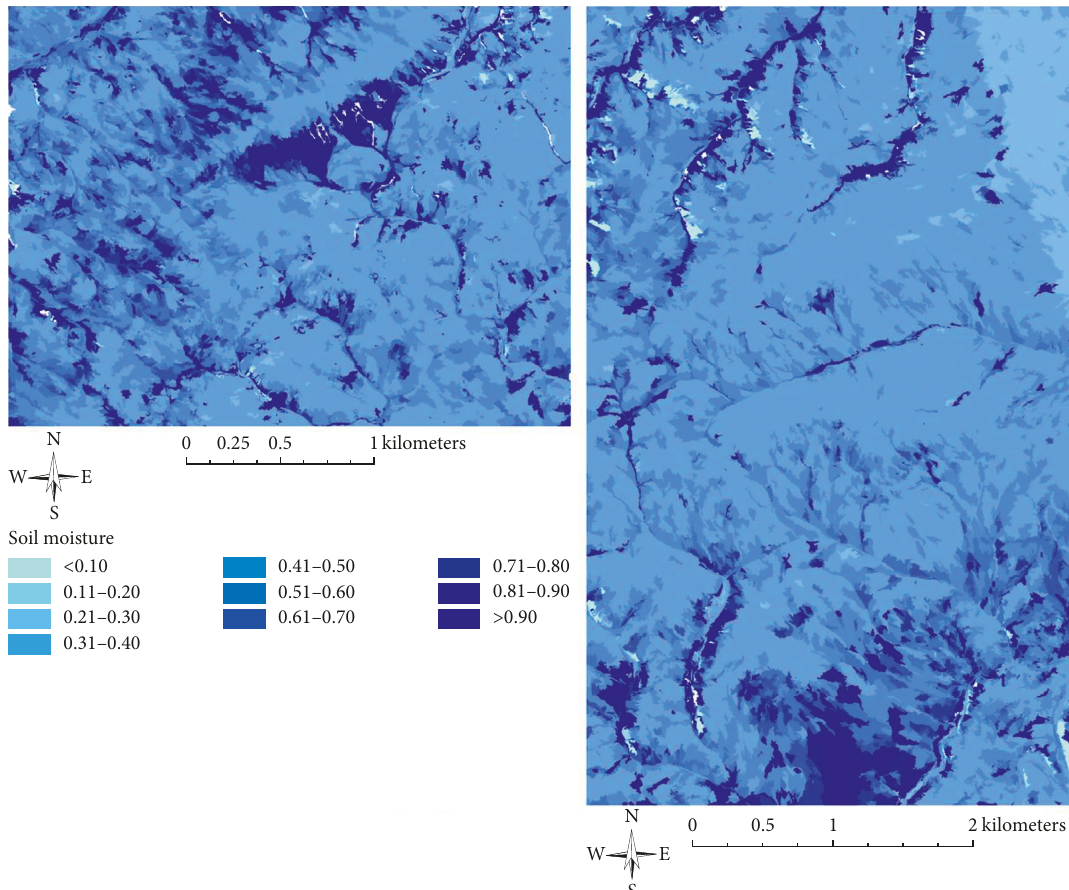
Figure 14: ANN-modelled soil moisture ( θ v ) values for the Cape Collingwood study area. The North subset is on the left, and the South subset is on the right. Values are from July 1,